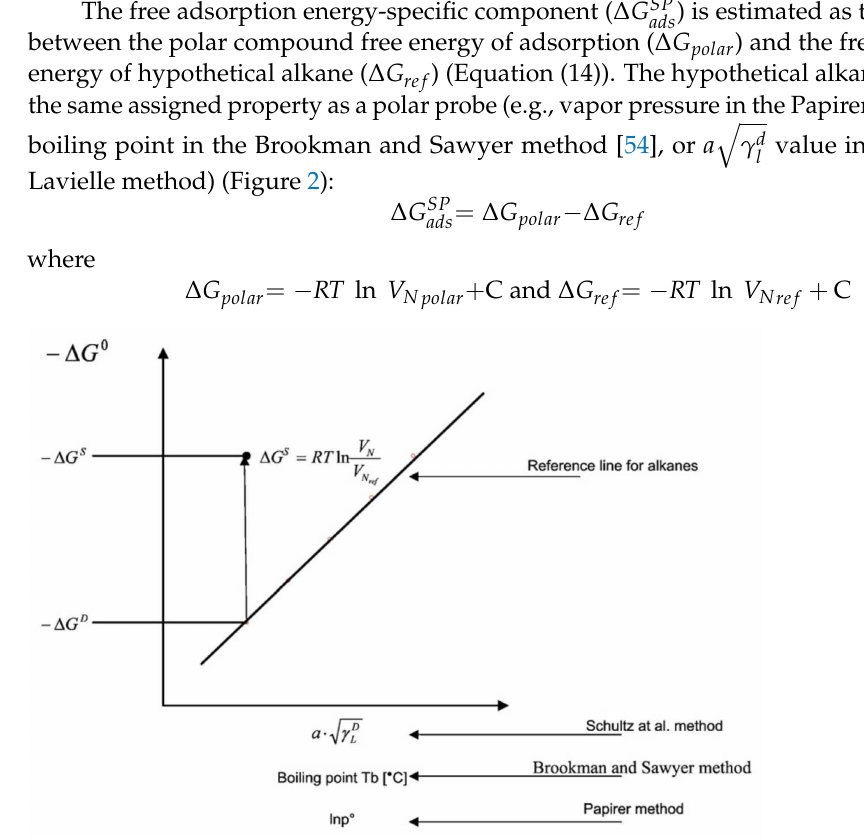
determination. Reprinted with permission from [16]. ads